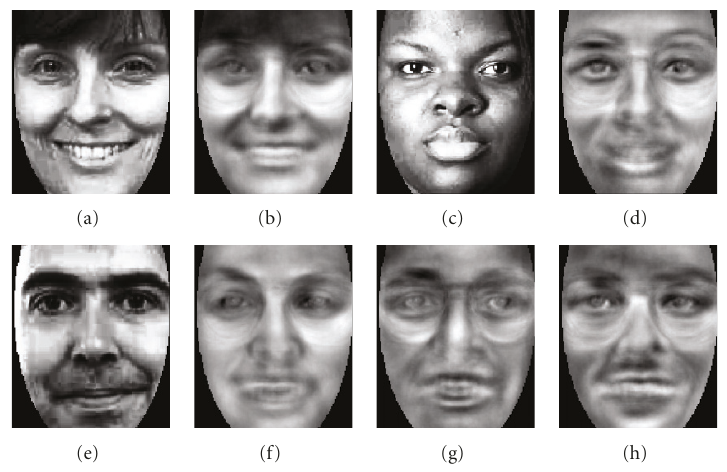
Figure 6: Comparison of original image with reconstructed images.